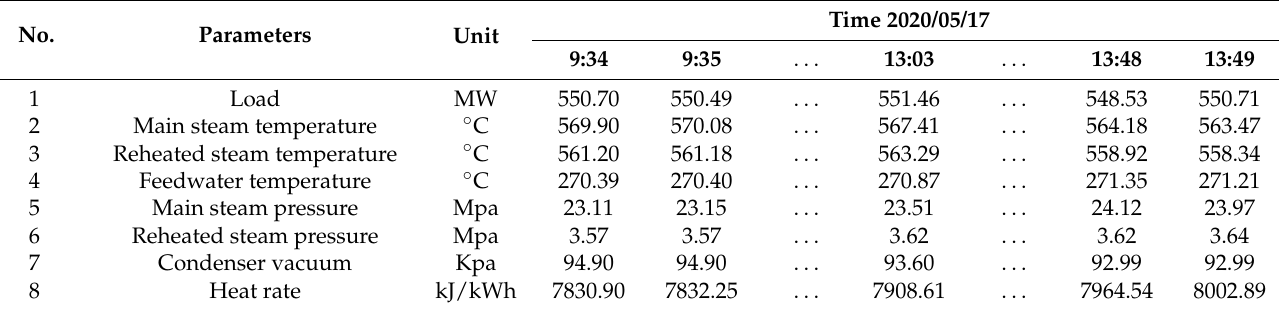
Table 5. Partial sample data for energy efficiency monitoring.